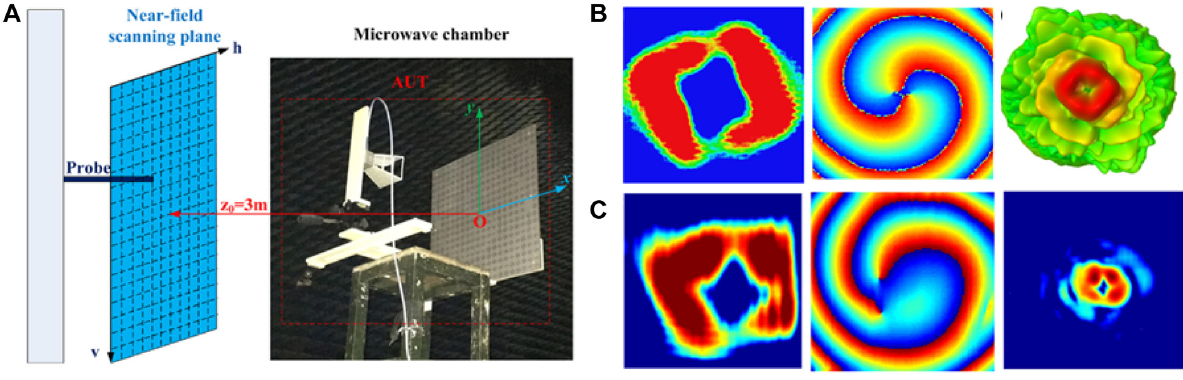
Figure 26: OAM vortex beam metasurface. (A) The reflective metasurface for orbital angular momentum vortex wave. (B) and (C) Simulation and measured results of the amplitudes, phases and patterns, respectively [120]. Reprinted from [120], with the permission of AIP